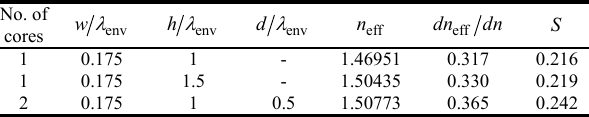
Table 1: Basic characteristics of the three optimal designs described above. No. of